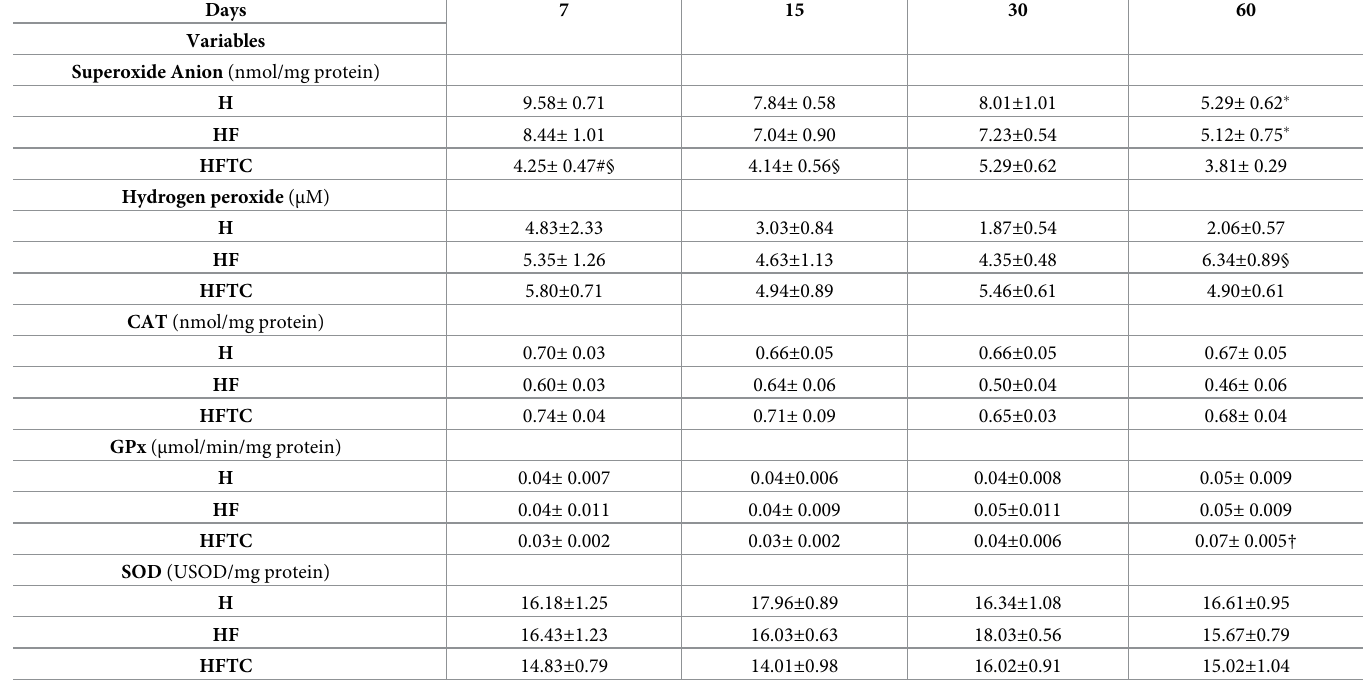
Table 3. Reactiveoxygen speciesand antioxidant enzymes in cardiac tissue of the Hypertensive (H), hypertensive + fructose (HF) and hypertensive + fructose + com- bined physical training (HFTC) groups at 7, 15, 30 and 60